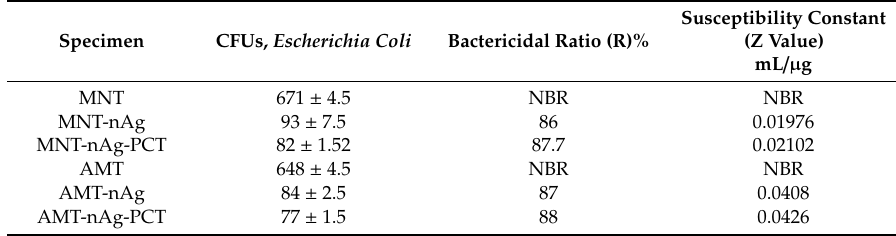
Table 4. Colony-forming units of the bacteria in each group, bactericidal ratios, and susceptibility constant for each developed